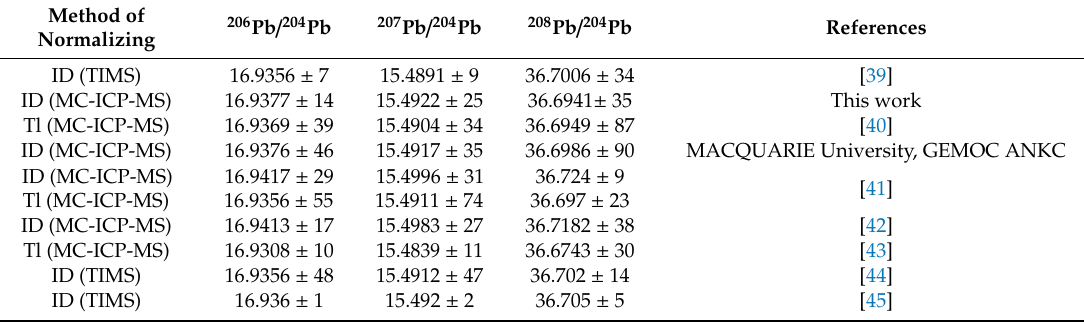
Table 1. Measured results for the SRM NBS-981 reference material obtained in di ff erent laboratories. Method of